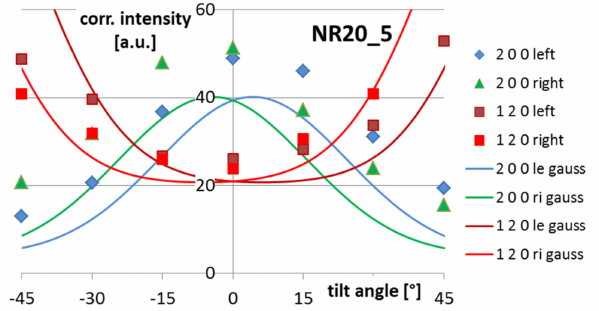
Figure 8. Intensities of the crystalline peaks of the sample NR20 with a stretch ratio of 5:1 in dependence of sample rotation, measured values (symbols) and values of the model (continuous lines) in analogy to Figure 5.